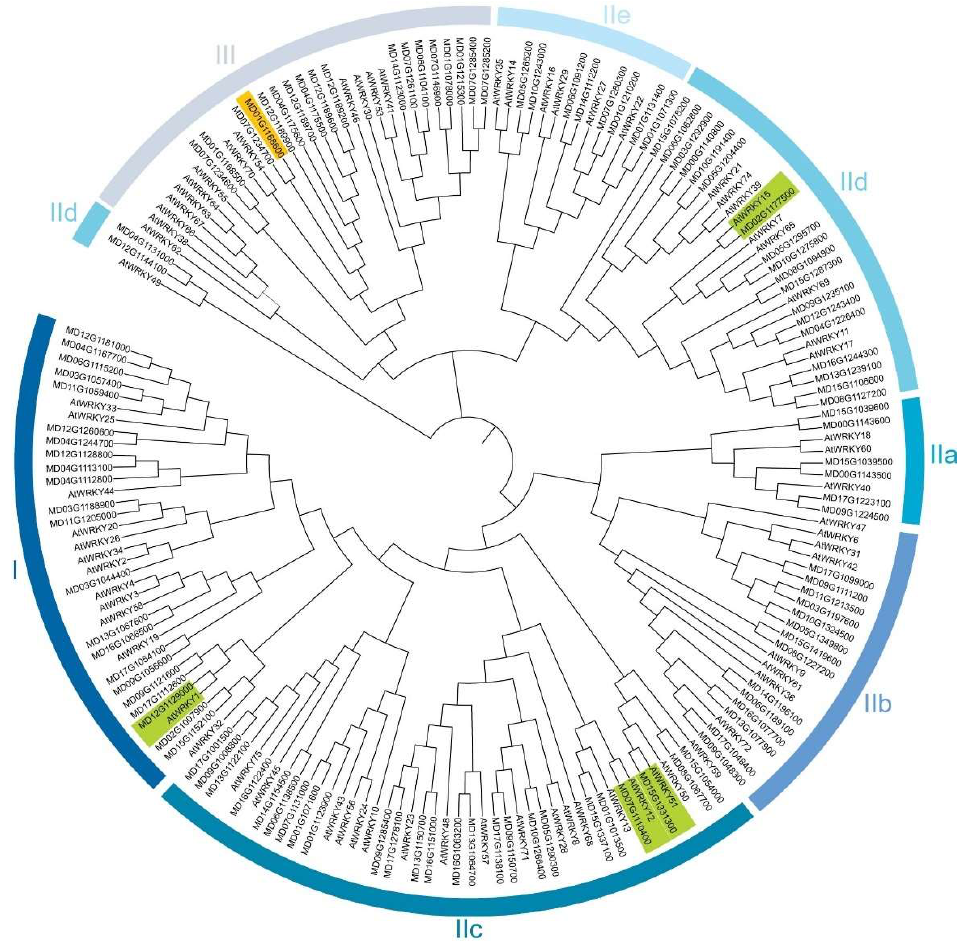
Figure 2. Phylogenetic tree of identified MdWRKY and AtWRKY proteins. Phylogenetic tree was constructed using MEGA-X program with the neighbor-joining (NJ) method. WRKY genes in each subgroup were shown with different colored arc. There were 71 AtWRKYs used in the figure and the sequence was downloaded from TAIR. The terminal branches of the phylogenetic tree connected an AtWRKY and an MdWRKY were marked with green. MdWRKY70L (MD01G1168600) was marked with orange.